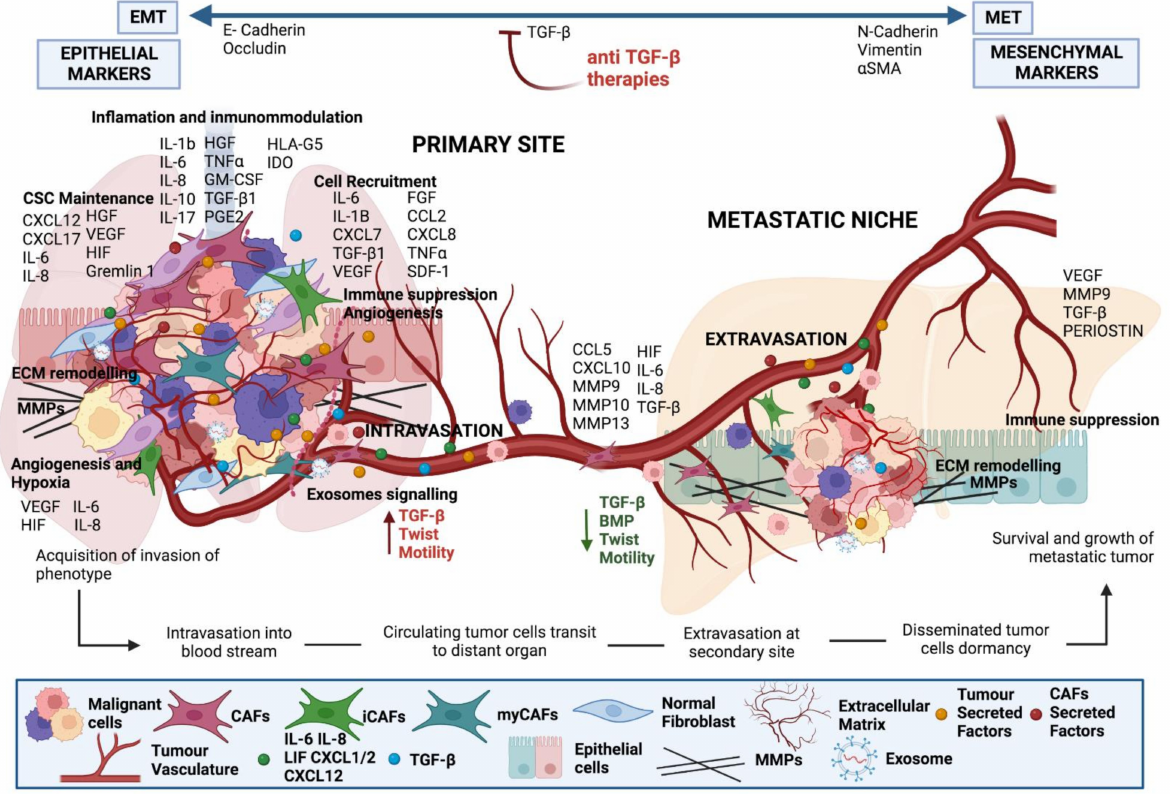
Figure 5. Crosstalk between tumour cells and CAFs at the primary tumour and metastatic site. Factors derived from cancer cells activate local fibroblasts to become CAFs. CAFs, in turn, produce interleukins to activate signalling in cancer cells increasing their metastatic potential. CAFs are chaperons of tumour cells as they support their survival and extravasation to the metastatic site, as well as preparing the premetastatic